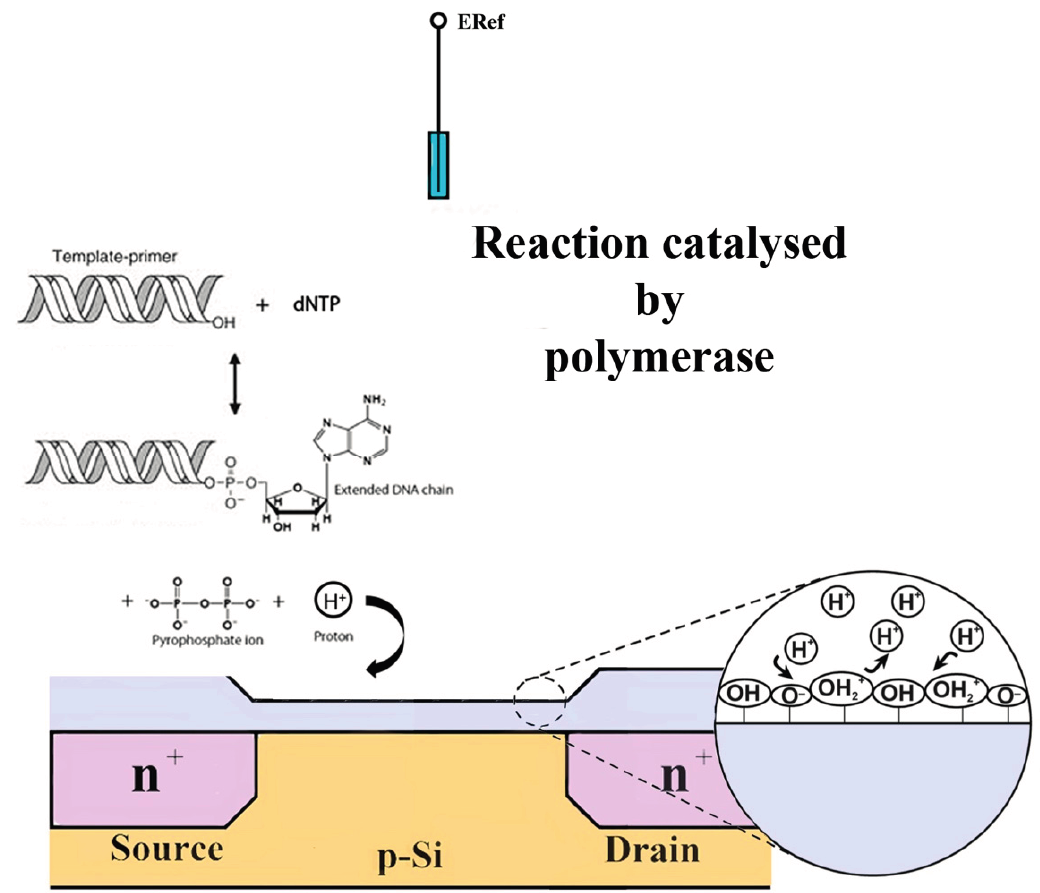
Figure 5. Structure and principle of function of an enzyme-based thin film field effect